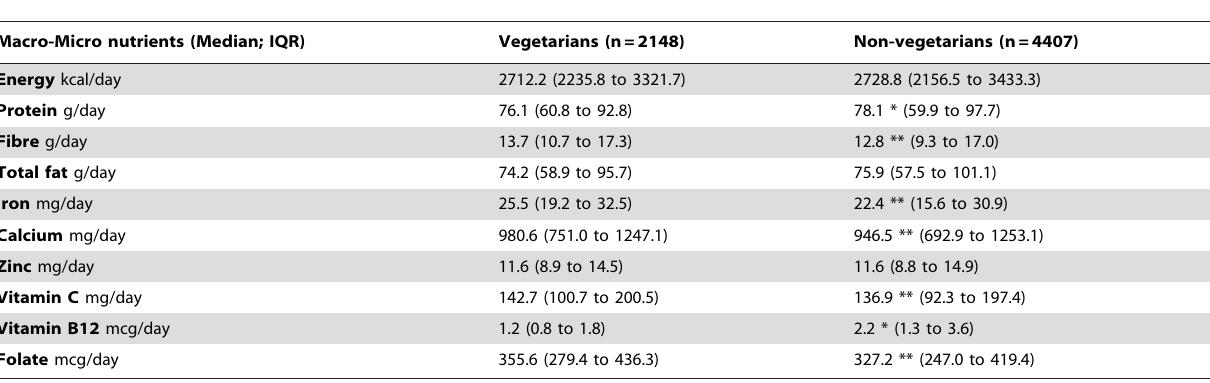
Table 2. Macro and micro-nutrient intake (estimated) of Indian Migration Study population.